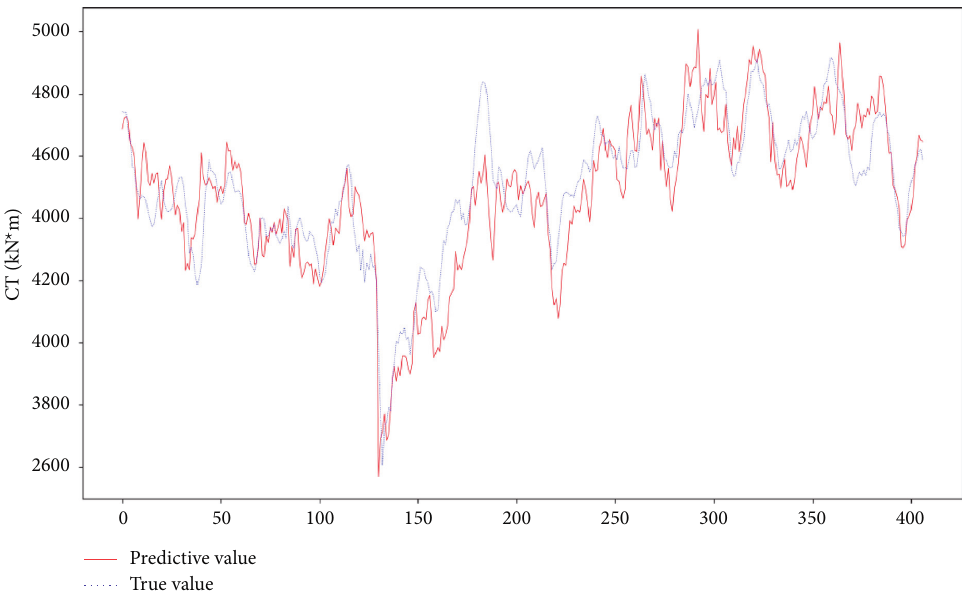
Figure 11: The prediction effect of LSTM